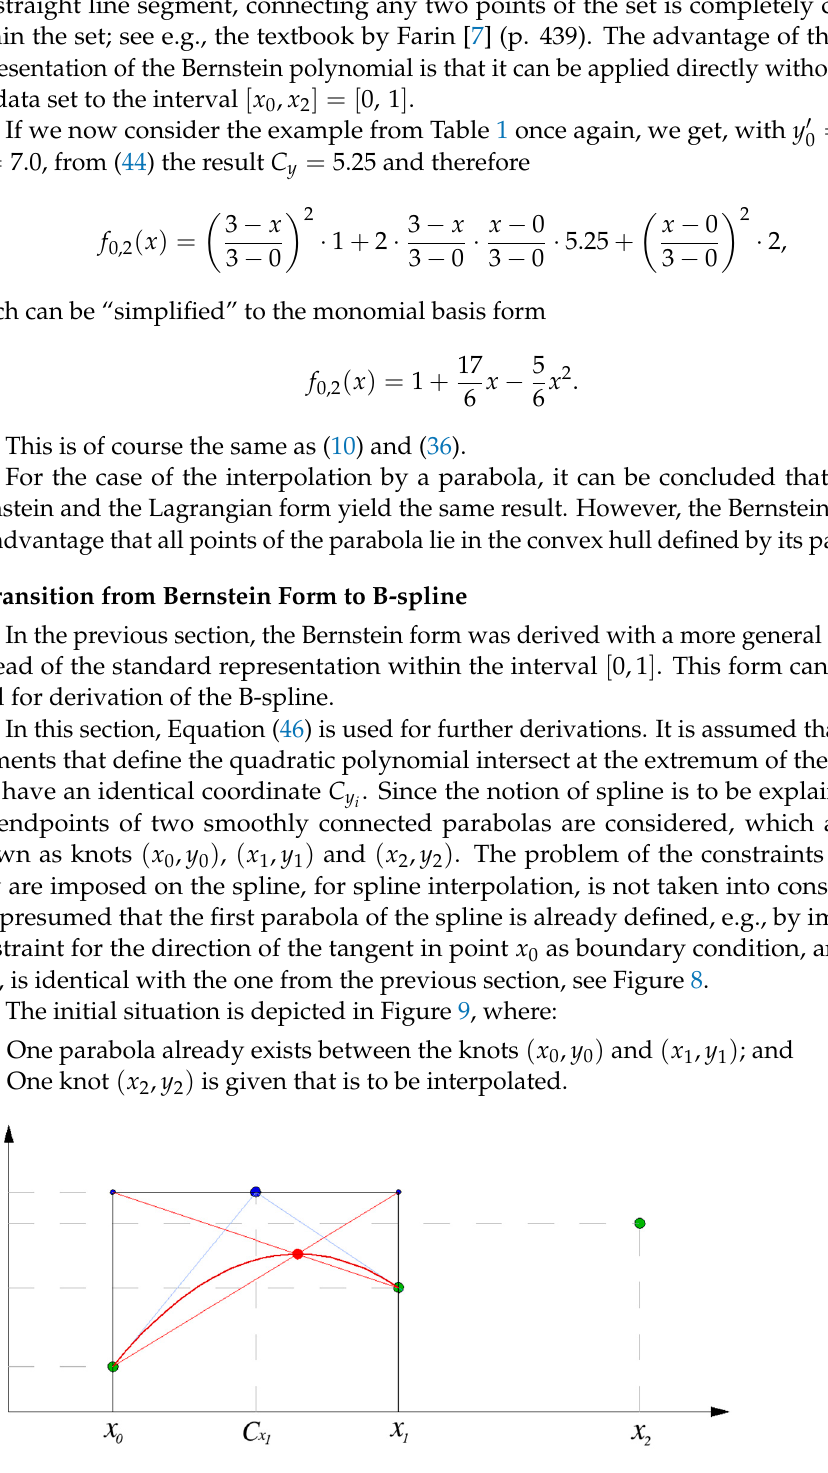
Figure 9. Initial situation before the construction of the second part of the spline. The extremum of the first parabola is marked with a red dot, the control point with a blue dot, and the green dots indicate points to be interpolated.